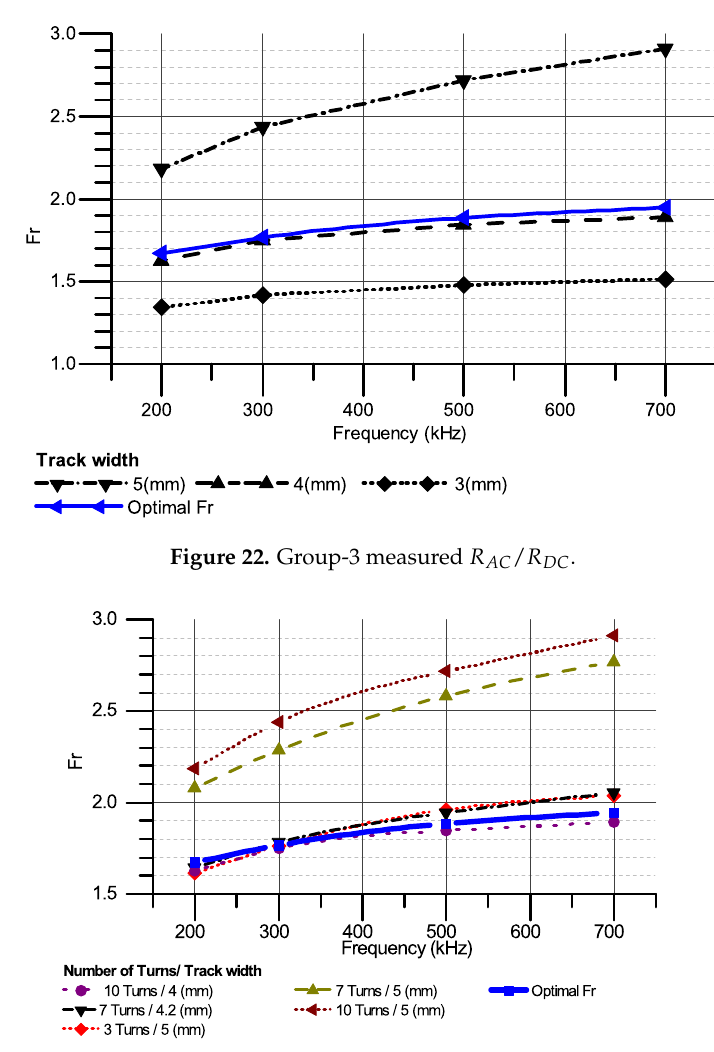
Figure 23. Measured F r of 3 group of windings with maximum track width and optimal track